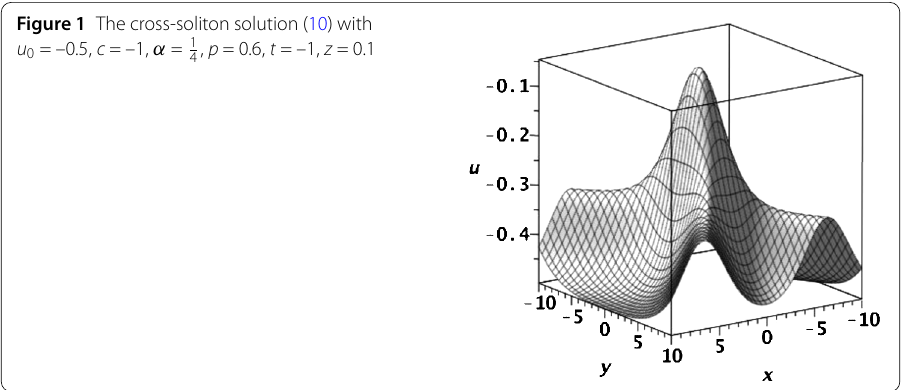
Figure 1 The cross-soliton solution (10) with